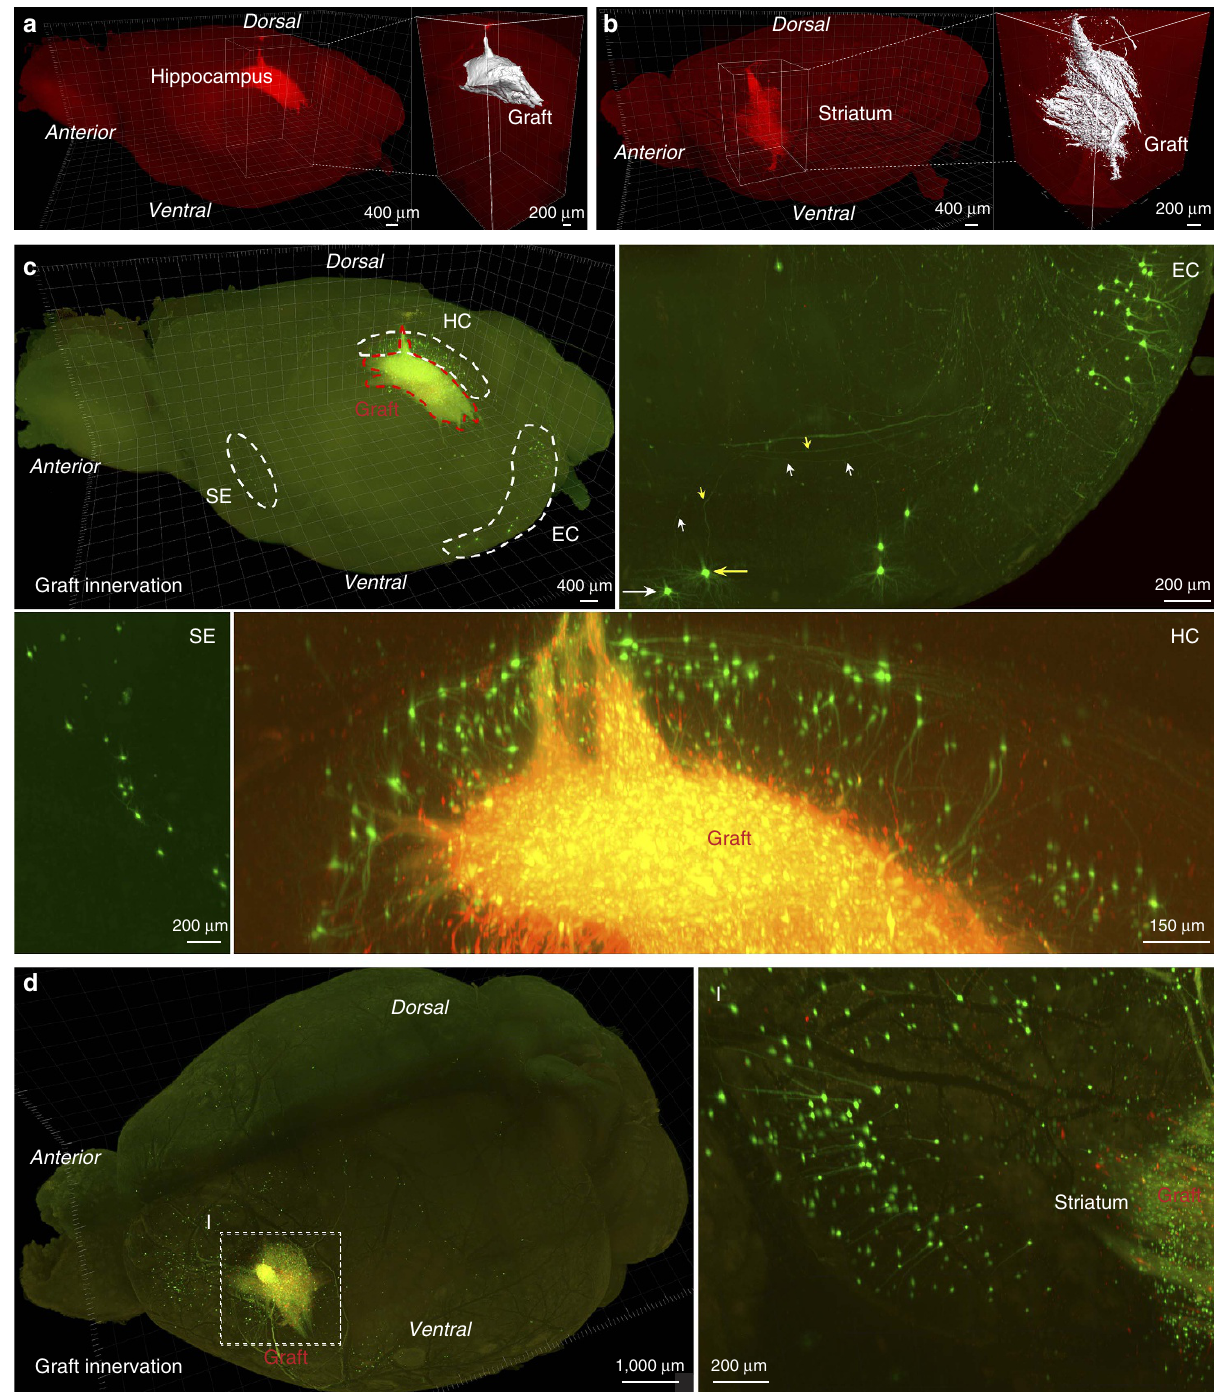
Figure 2 | Whole-mount imaging of grafted human lt-NES cells. ( a , b ) Human grafts in the hippocampus ( a ) and striatum ( b ) as detected by their mRFP1 expression. Insets depict magnified graft cores as determined by 3D surface rendering. ( c , d ) Co-visualization of mRFP1 and EGFP fluorescence identifies RABV D G-EGFP-infected donor cells while exclusively EGFP þ cells represent retrogradely labelled host neurons connected to engrafted neurons. ( c ) Hippocampal grafts (HC) receive orthotopic input from the entorhinal cortex (EC; coloured arrows indicate neurons and their corresponding axon), the septum (SE) and intrahippocampal host neurons within the pyramidal cell layer and stratum oriens. Striatal grafts ( d ) are largely innervated by cortical neurons as well as adjacent striatal neurons. Shown are representative images from n ¼ 3 cleared brains per transplantation site; scale bars as